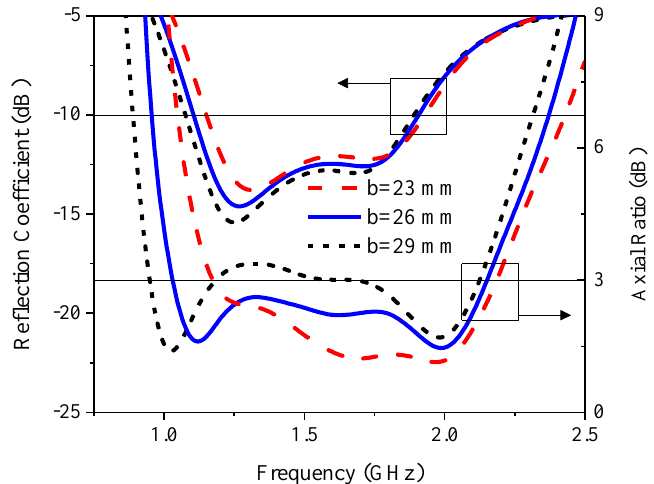
Figure 12. The simulated reflection coefficient and axial ratio under variable branch dimensions ( b